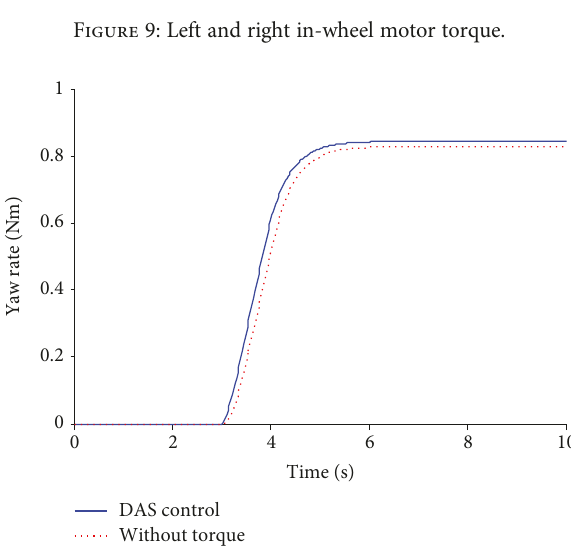
Figure 10: Comparison of vehicle yaw rate.